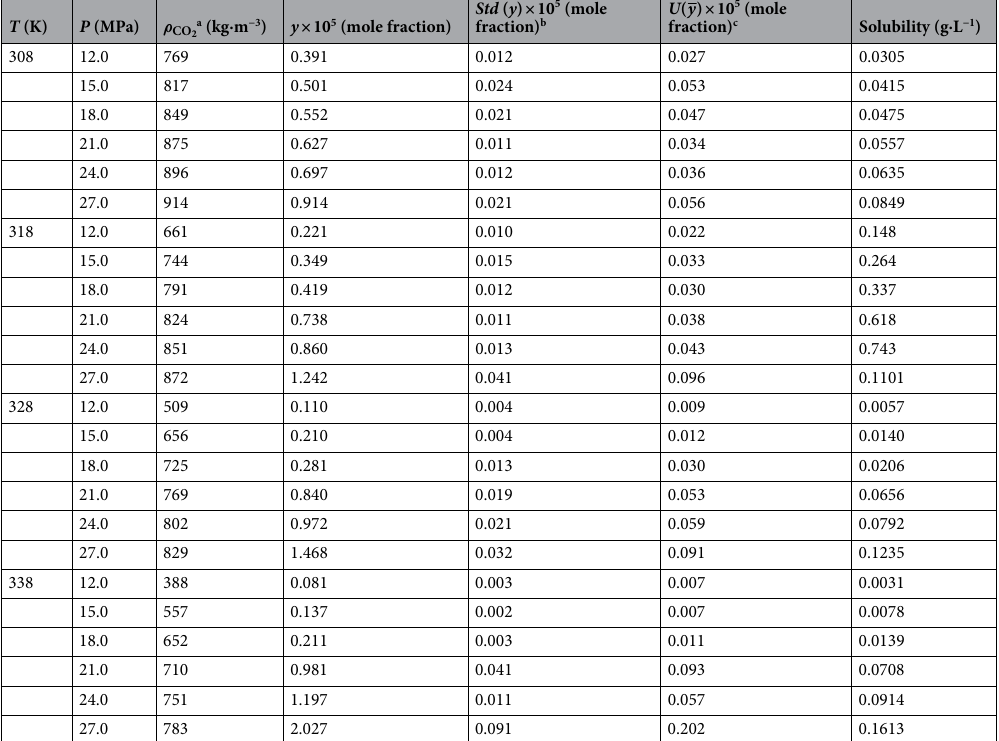
Table 2. Experimental data of palbociclib solubility in ScCO 2 . *Standard uncertainty values ( u ) for temperature and pressure are u ( T ) = 0.1 K and u ( P ) = 0.1 MPa. a CO 2 density was obtained from national institute of science and technology (NIST) chemistry webbook (http:// webbo ok. nist. gov/ chemi stry/). b Experimental standard deviation was obtained by Std determined from U ( y ) = k · u comb with the coverage factor k = 2 (the level of confidence of approximately 95%) and the relative combined standard uncertainty u comb / ¯ y =